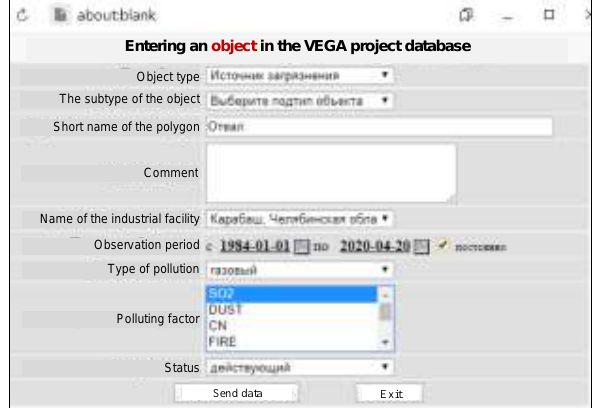
Figure 3. Registration of TWDS